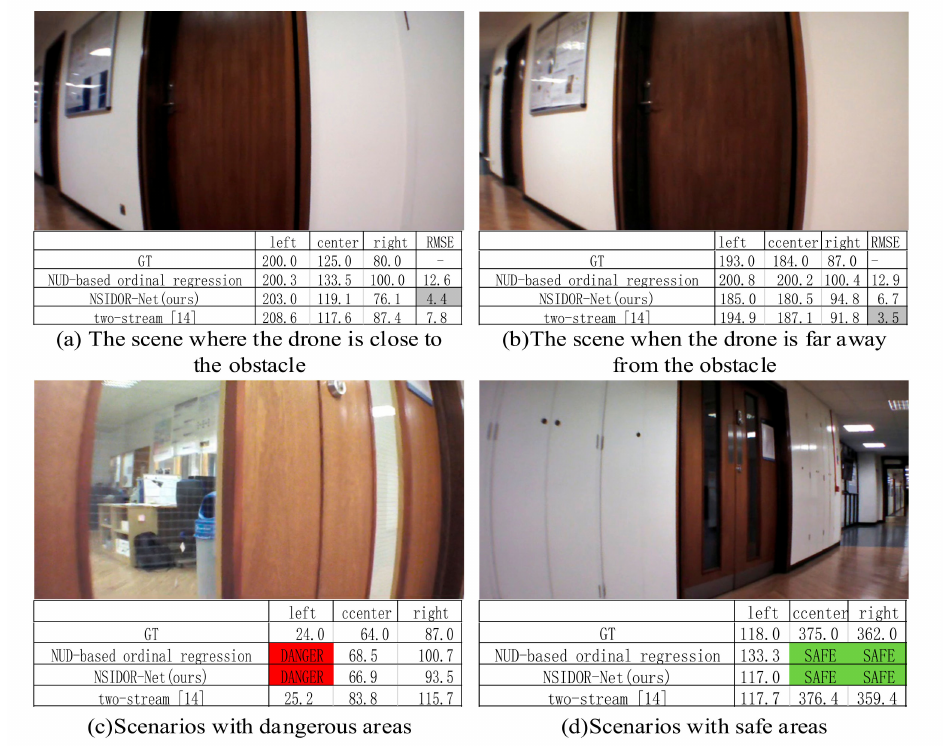
Figure 9. The prediction results of each algorithm on the actual